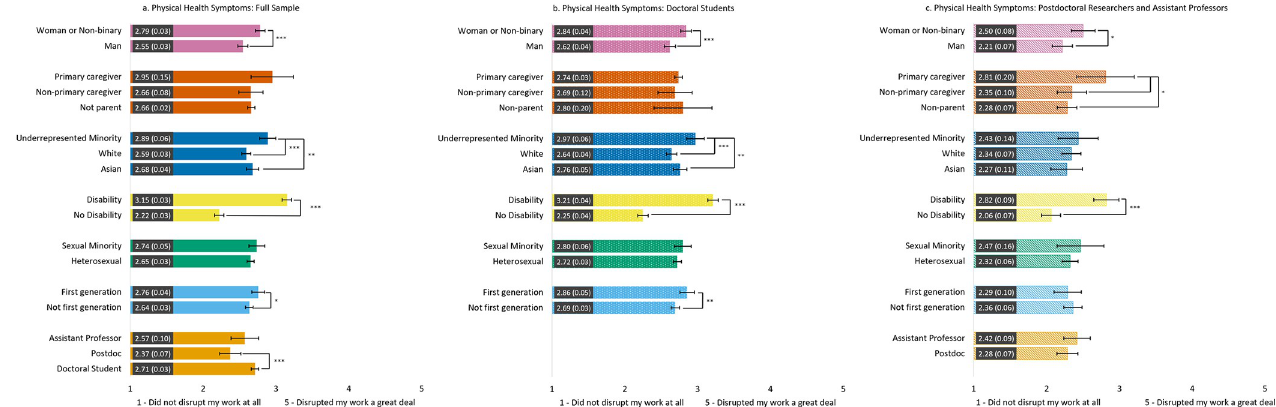
Fig 5. Estimated marginal means of disruptions to work due to physical health problems during the COVID-19 pandemic for the full sample (5a) and the doctoral student (5b) and postdoc/asst prof (5c) subsamples. Participants were asked to rate the degree to which physical health problems due to the COVID-19 pandemic disrupted their work with a Likert scale from 1 = Did not disrupt my work to 5 = Greatly disrupted my work . Error bars represent the 95% CI. Numeric values in each bar are the estimated marginal mean and standard error. � indicates p < .05, �� indicates p < .01, and ��� indicates p < .001. See S7 Table in S1 File for results of each